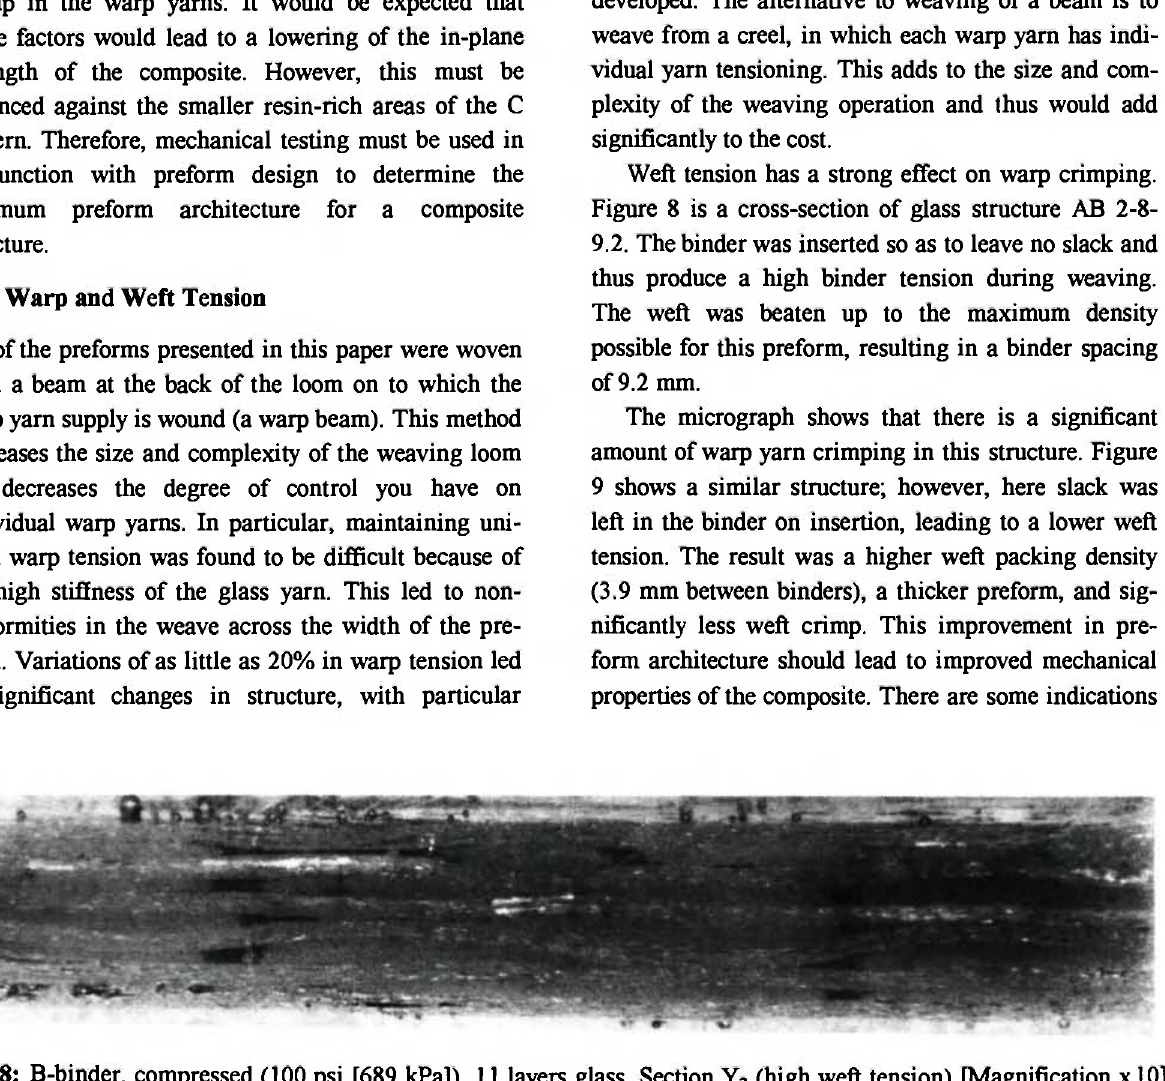
[Magnification χ 10]. 3 effect on the bunching and crimping of warp